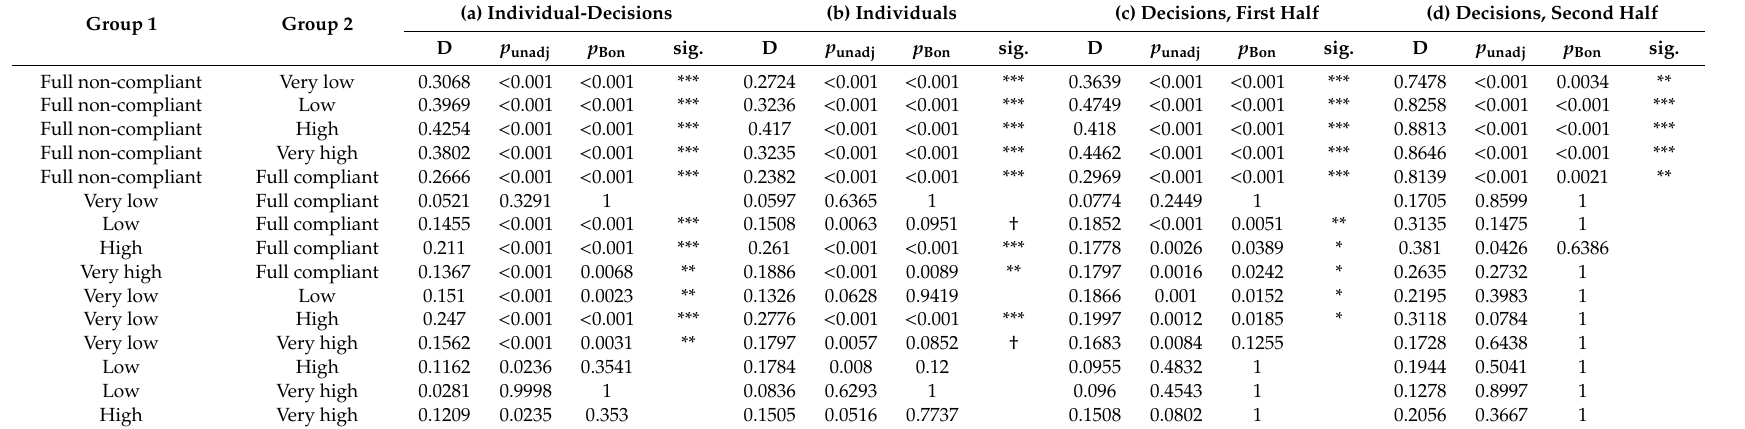
Table 3. Two-sample Kolmogorov-Smirnov test of declaration time by tax compliance level, for Figure